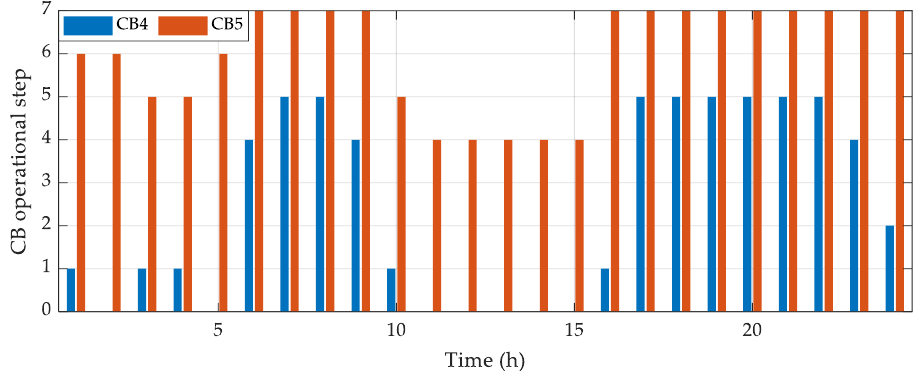
Figure 9. Operational step for the capacitor banks for the selected day.